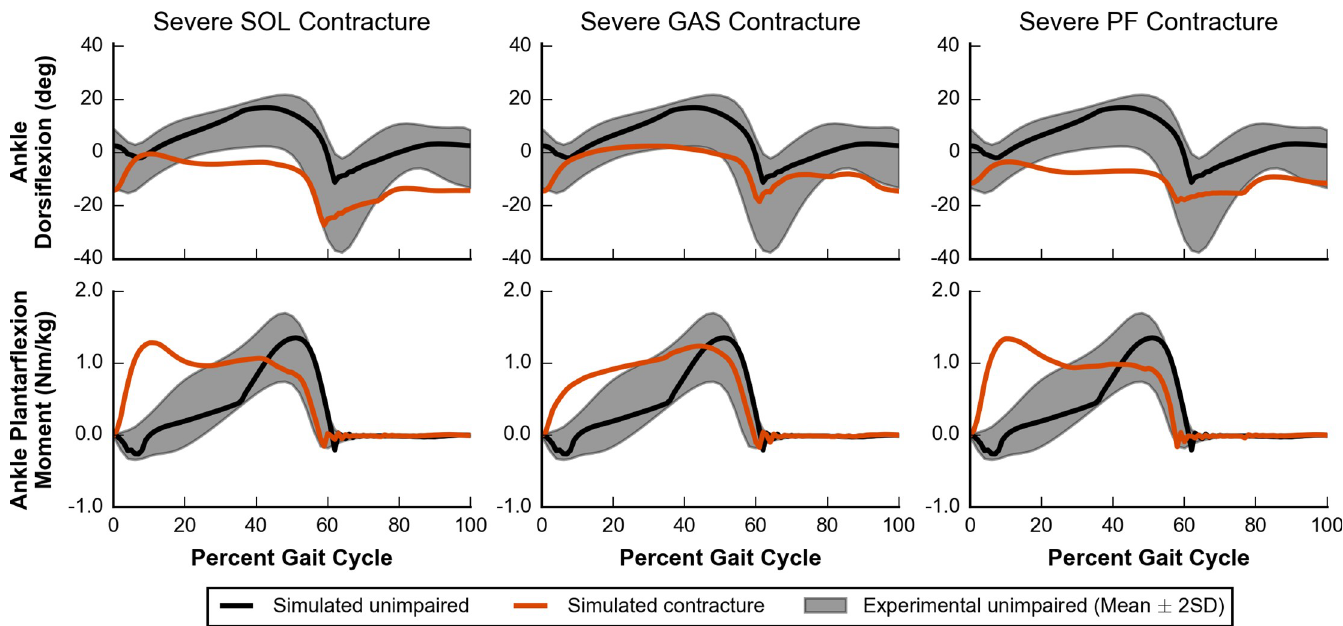
Fig 10. Ankle kinematics and kinetics for severe contracture. Simulated ankle kinematics and kinetics for unimpaired walking (black lines) and walking with severe contracture (orange lines) are compared to experimental data of unimpaired individuals (gray area) [58]. Ankle dorsiflexion (top) and ankle plantarflexion moment (bottom) are plotted for cases of SOL (left), GAS (middle), and PF (right) contracture.